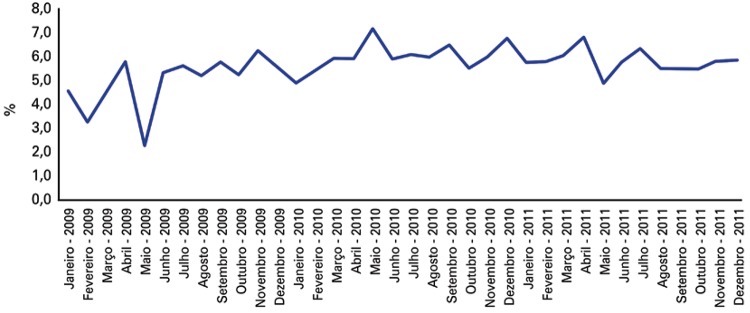
 Evolução do rendimento médio, ao longo dos meses, no período 2009-2011